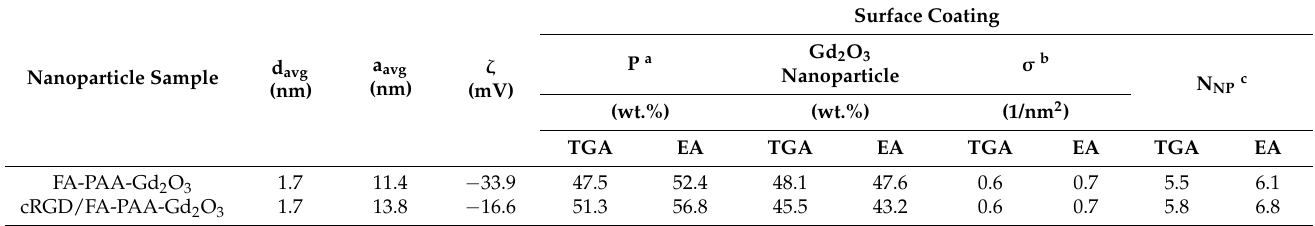
Table 1. Physicochemical properties of FA-PAA-Gd 2 O 3 and cRGD/FA-PAA-Gd 2 O 3